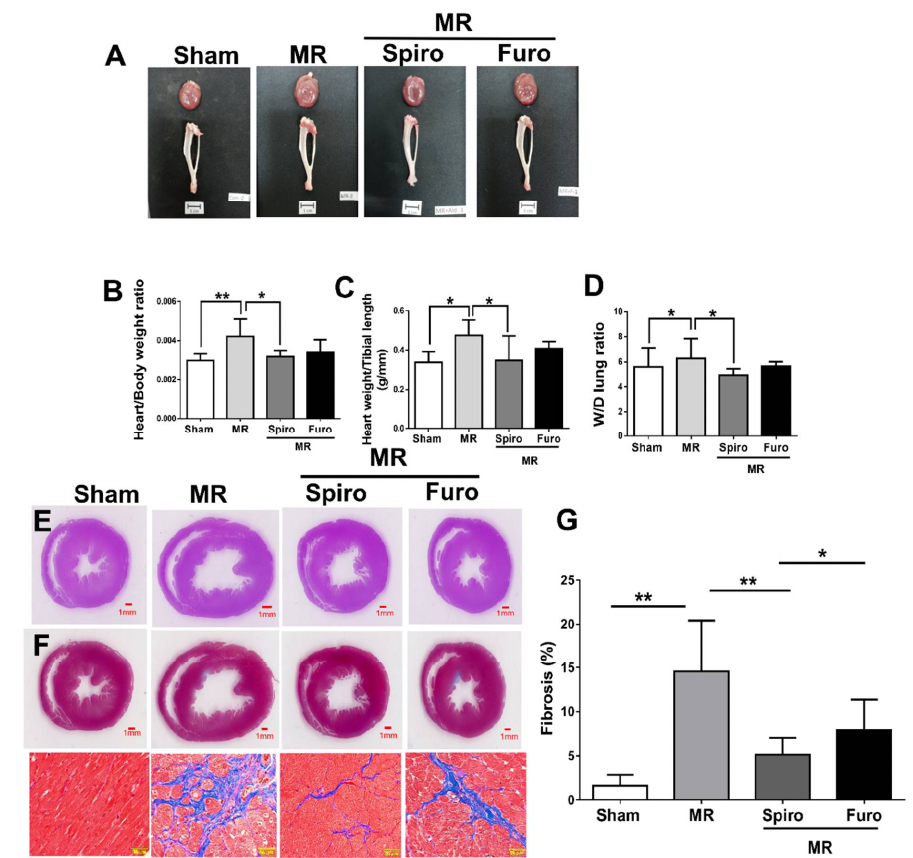
Figure 3. Effects of mineralocorticoid receptor antagonists on cardiac injury and fibrosis in rat model of mitral regurgitation (MR). ( A ) Images of harvested hearts and tibia in each group. ( B ) Representative heart weight/body weight, ( C ) heart weight/tibial length, ( D ) wet-to-dry lung weight ratio. ( E ) Images of heart sections with H&E staining and ( F ) Masson trichrome staining (blue) in the indicated groups; scale bars, 50 µm. ( G ) Quantification of cardiac fibrosis in the indicated groups of rats. Data are expressed as the mean ± standard deviation (S.D.). * p < 0.05 and ** p < 0.01 for differences from each group.